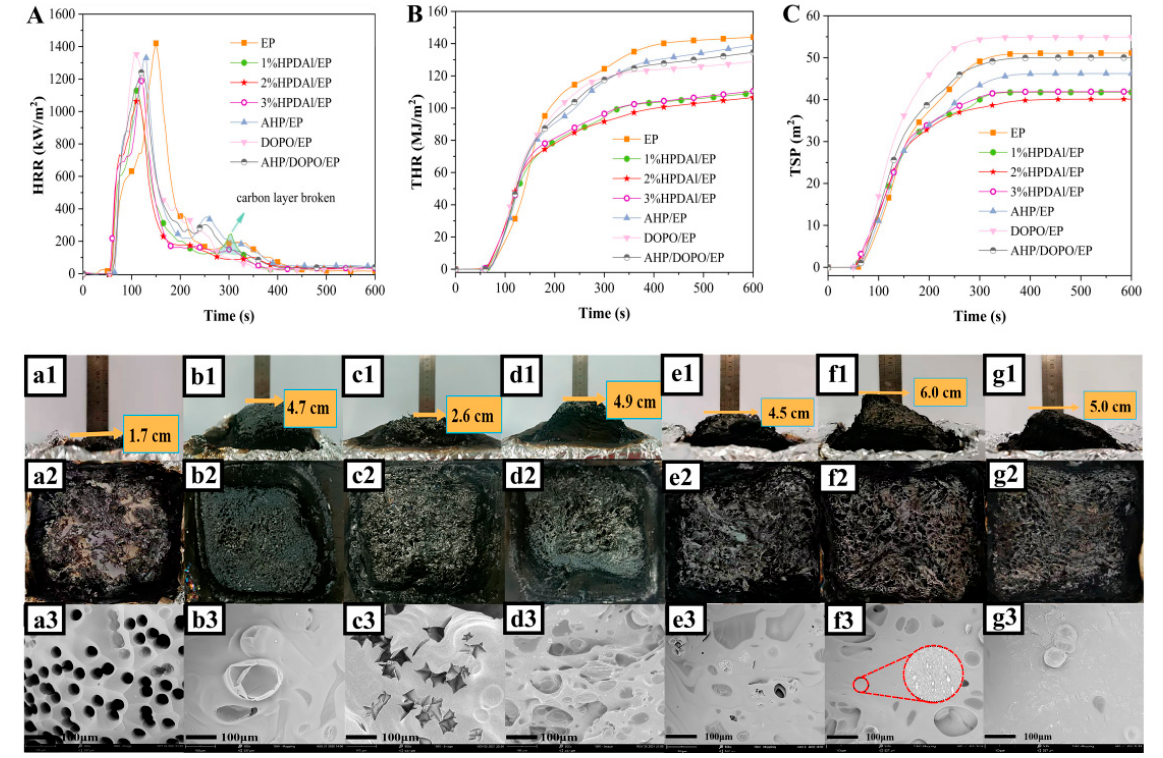
Figure 4. HRR ( A ), THR ( B ) and TSP ( C ) curves of EP and EP composites, macroscopic photos and SEM images (×500) of residues for EP ( a1 – a3 ), AHP/EP ( b1 – b3 ), DOPO/EP ( c1 – c3 ), AHP/DOPO/EP ( d1 – d3 ), 1%HPDAl/EP ( e1 – e3 ), 2%HPDAl/EP ( f1 – f3 ) and 3%HPDAl/EP ( g1 – g3 ) after cone test.